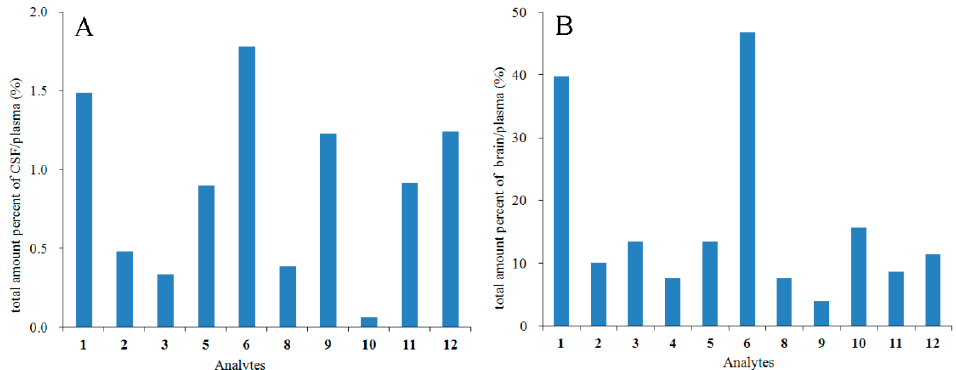
Figure 5. Total amount percentage of tested compounds in rat CSF ( A ) and brain ( B ) after oral administration of APRE.